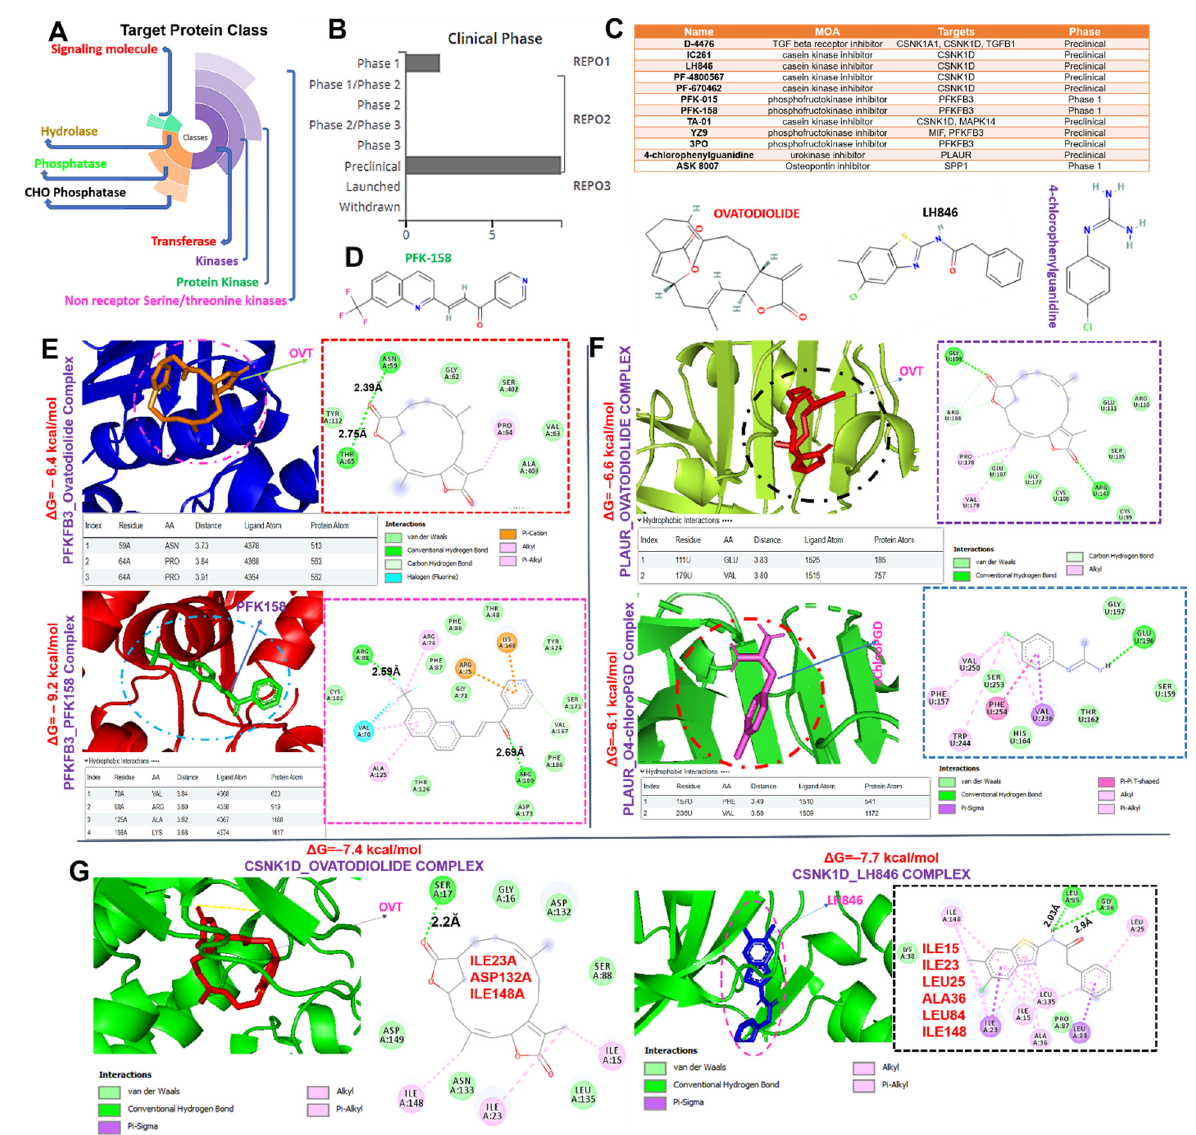
Figure 7. Therapeutic target exploration and comparative docking profile between ovatodiolide and standardized drugs. ( A ) Target protein class, ( B ) clinical phase, ( C ) mechanism of action, and ( D ) chemical structures of validated target inhibitors for the members of the MTSCPPC signature. Three- (3D) and two-dimensional (2D) structures of ligand–receptor complexes, showing interacting amino acid residues and the types of interactions occurring between the ligand (ovatodiolide and standardized drugs) and receptors: ( E ) MAN2A2, ( F ) PLAUR, and ( G ) CSNK1D.